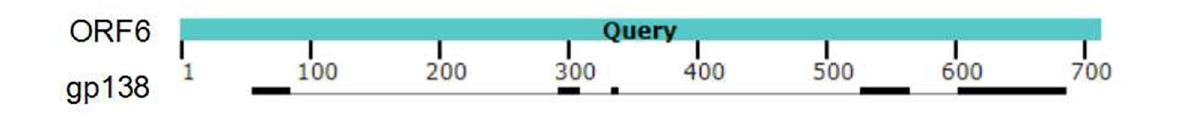
FIGURE 6 | Analyses of the sequences of ORF6 and gp138. Identical regions were highlighted in